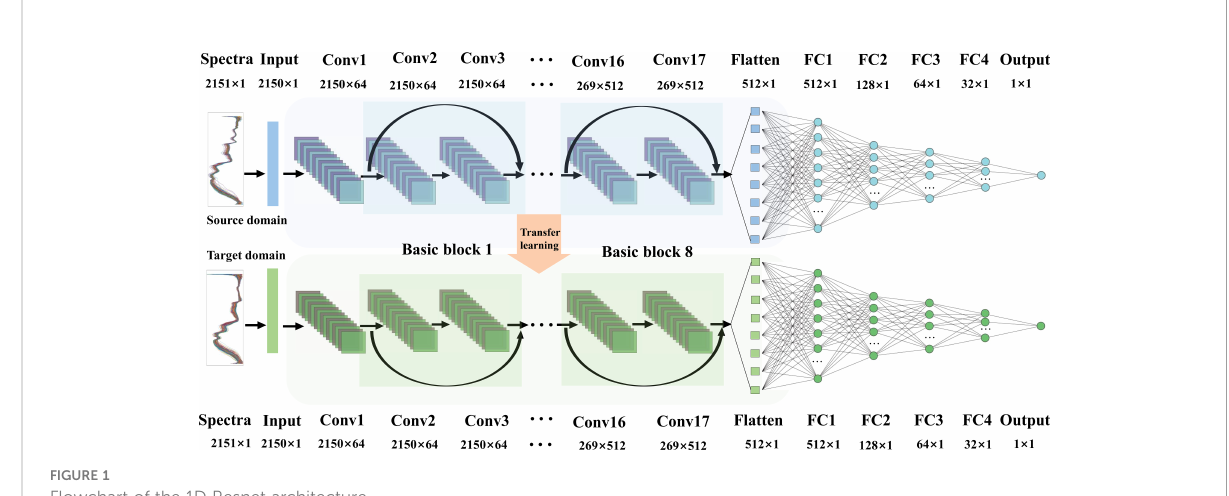
FIGURE 1 Flowchart of the 1D Resnet